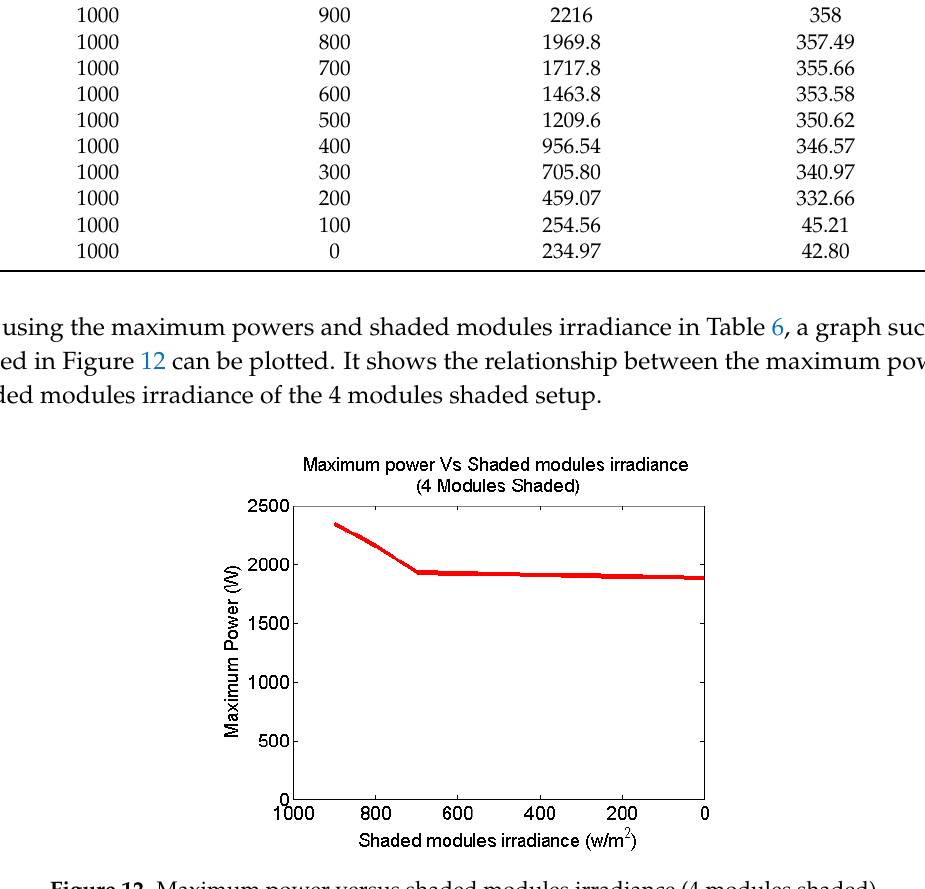
Figure 12. Maximum power versus shaded modules irradiance (4 modules shaded).